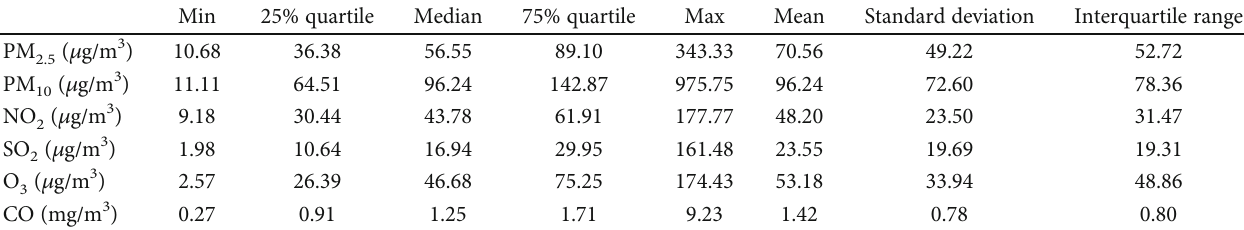
Figure 1: Monthly distribution of new-onset diabetes during 2014 to 2017. Table 2: Air pollutants in Binhai New Area during 2014 to 2017.